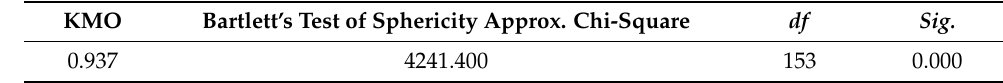
Table 4. KMO and Bartlett’s Test. KMO Bartlett’s Test of Sphericity Approx. Chi-Square df Sig. 0.937